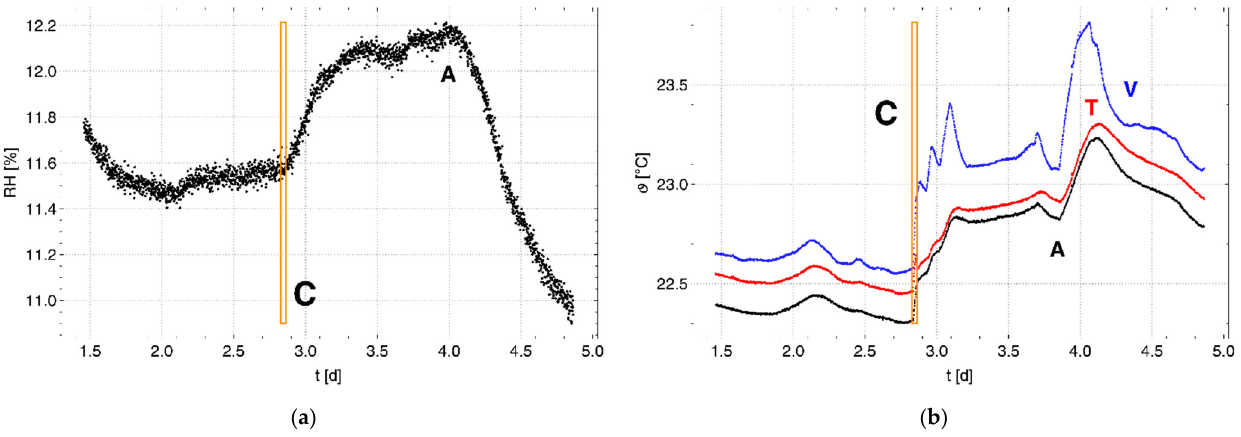
Figure 4. ( a ) Relative humidity in the air container and ( b ) temperatures in the containers of the test system (T: red, V: blue, A: black). The orange box marked C indicates the change from Phase 1 to Phase 2.